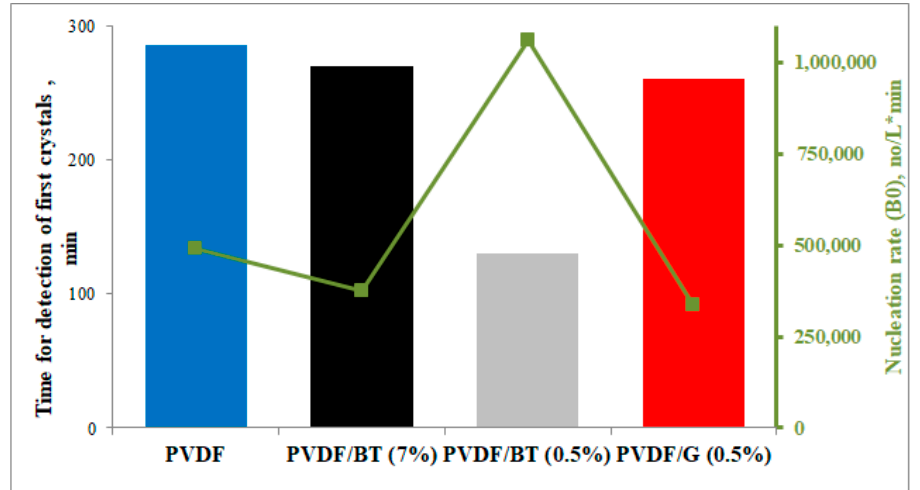
Figure 6. Time for detection of the first crystals and nucleation rate for the PVDF-pristine mem- brane and PVDF functionalized membranes. and PVDF functionalized